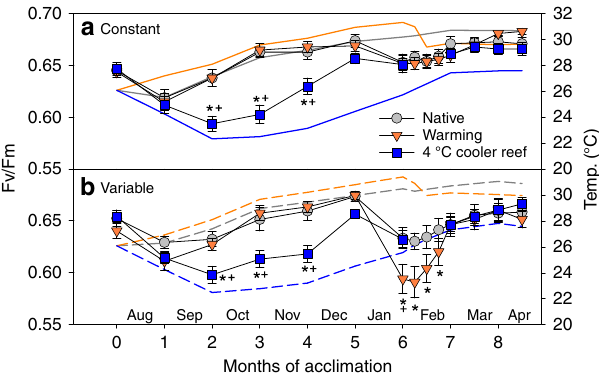
Fig. 2 Photochemical ef fi ciency (Fv/Fm) during the acclimation phase. Acropora aspera corals were maintained under a constant daily temperatures or b 4 °C daily temperature variability. Solid and dashed lines represent monthly tank temperatures for each treatment (Table S2). Mean ± 1 S.E.M. is shown. Asterisks indicate a signi fi cant difference from the